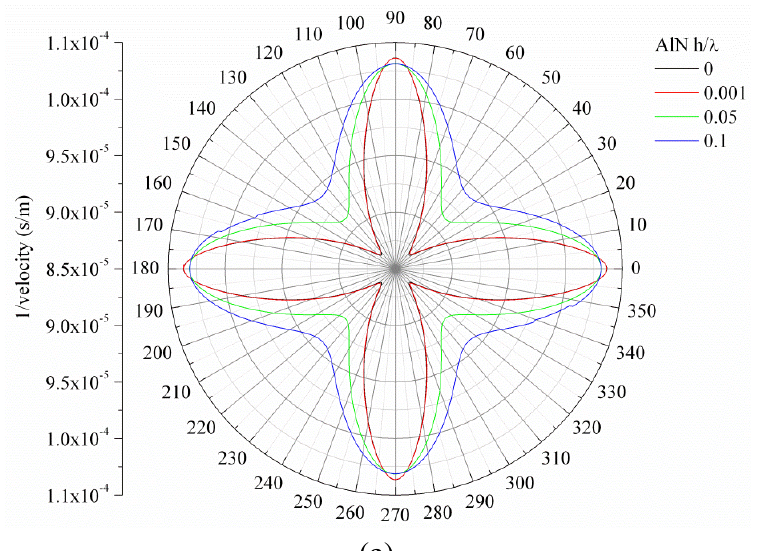
Figure 1. Slowness curves. ( a ) Slowness curves of the S plate (0.1 h/ λ thick) covered by an AlN layer; ( b ) slowness curves of the A propagating along 3C-SiC plate (0.1 h/ λ thick) covered by an AlN layer. In both cases the AlN h/ λ (0, 0.001, 0.05 and 0.1) is the running